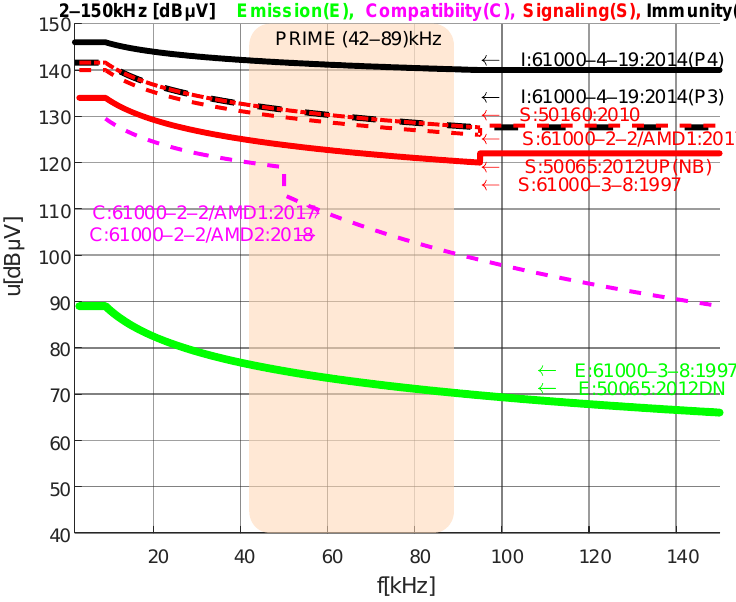
Figure 3. Comparison of the emission (E), compatibility (C), mains signalling (S), and immunity (I) levels for conducted disturbances and signalling in the frequency range 2–150 kHz (based on standards [16–21].